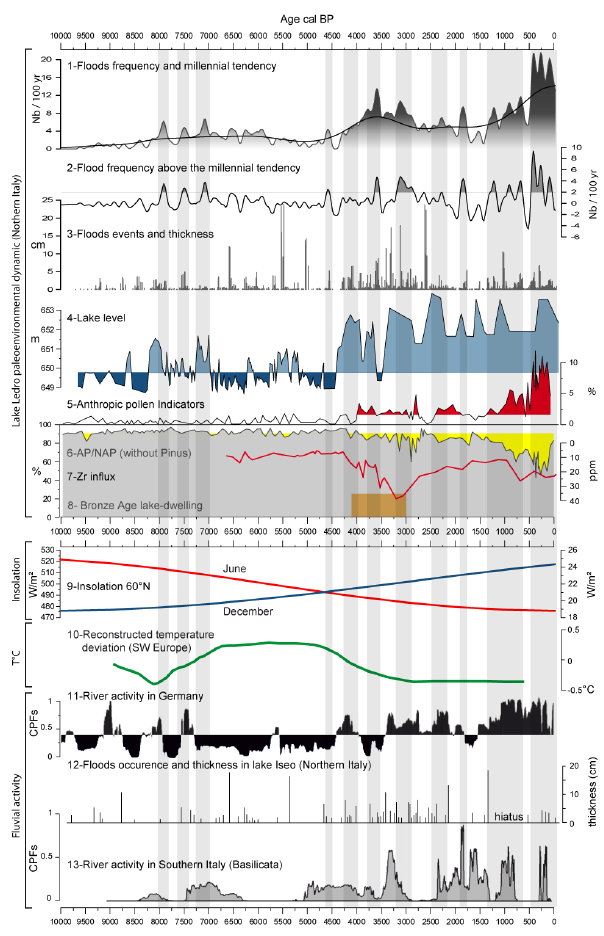
Fig. 7. Lake Ledro’s results compared with other regional and con- tinental records of climate and environmental changes. 1 – Flood- deposit frequency, with the millennial trend; 2 – Submillennial flood deposit frequency, i.e. above the millennial trend (dashed: 2 times greater); 3 – Flood events and thicknesses (1 to 3: Lake Ledro deep cores LL08-1 & 2; this study); 4 – Lake Ledro lake levels (littoral cores; Magny et al., 2012); 5 – Anthropogenic pollen (see text for the list of taxa); 6 – Arboreal pollen (5 & 6: Ledro deep core LL08- 1; Joannin et al., 2013); 7 – Zr ICP-AES concentration (Ledro deep core LL08-1); 8 – Chronology of the Bronze Age lake dwellings (see location on Fig. 1a; Pinton and Carrara, 2007); 9 – June and December insolation at 60°N (Berger and Loutre, 1991); 10 – Re- constructed deviation of summer temperatures from pollen data for SW Europe (Renssen et al., 2009); 11 – Cumulative probability den- sity functions of 14 C dates associated with major floods in Germany (Hoffmann et al., 2008); 12 – Flood events and thicknesses from Lake Iseo (50km SW from Lake Ledro; Lauterbach et al., 2012); 13 – Cumulative probability density functions of 14 C dates associ- ated with major flooding in Basilicata, southern Italy (Piccarreta et al., 2011). Grey bands underline periods of flood frequency increase at Lake